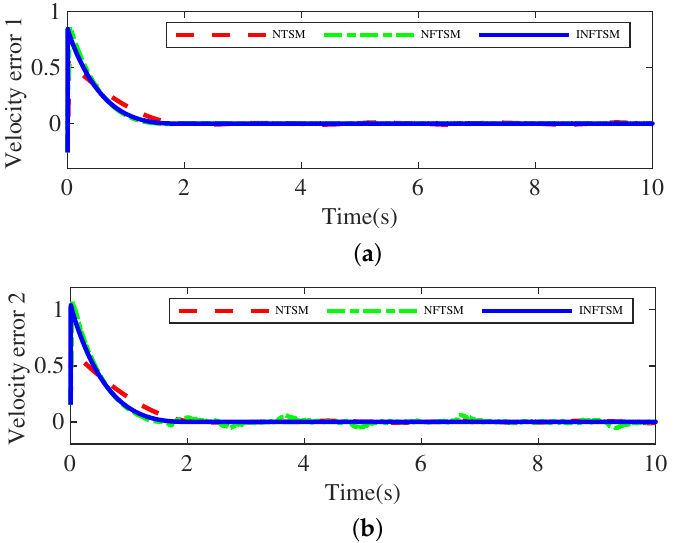
Figure 4. Comparison of velocity error when the system is in normal situation: ( a ) at joint 1 and ( b ) at joint